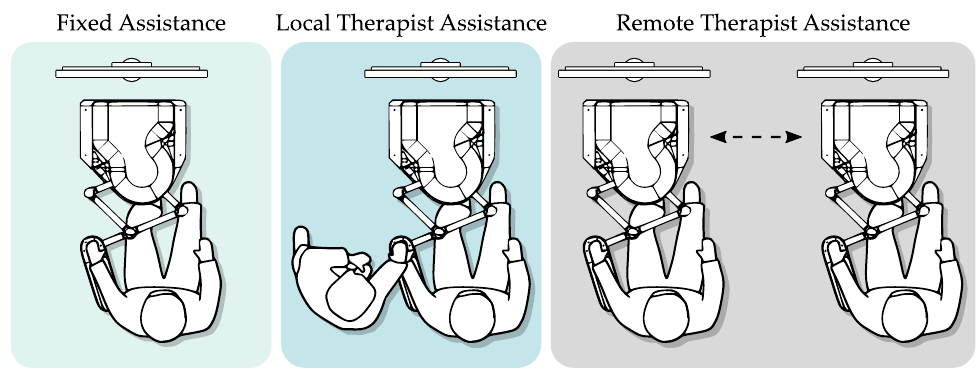
Figure 4. Graphical representation of the different assistance modes evaluated.